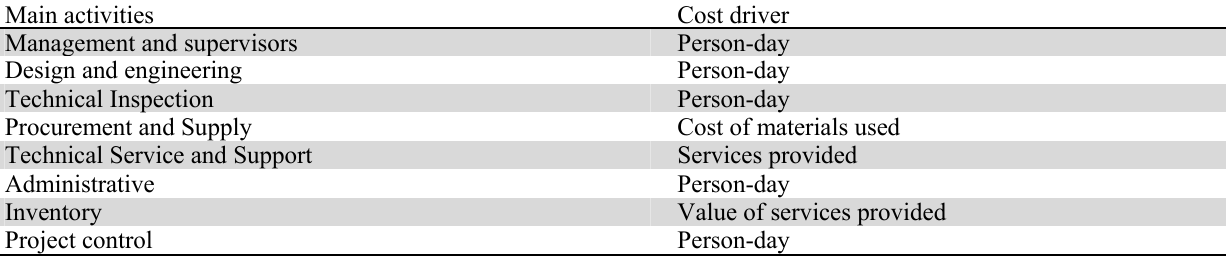
The summary of main components of the project